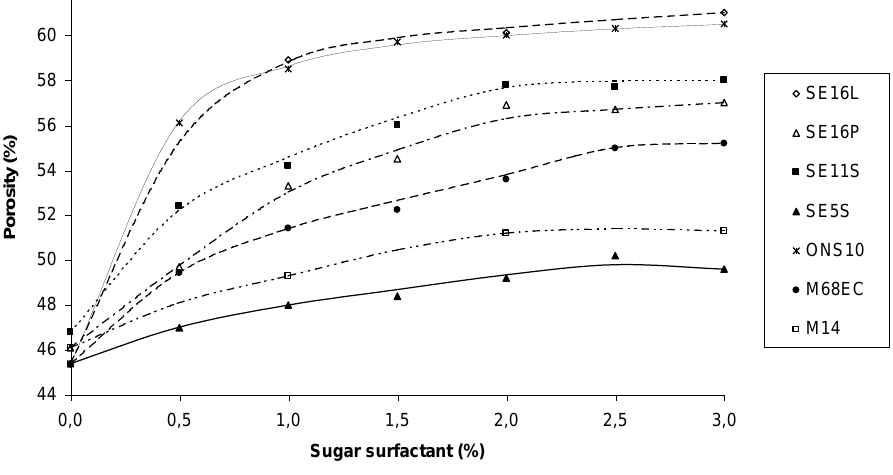
Figure 2. Porosity as a function of sugar surfactant measured from the volume increase of the